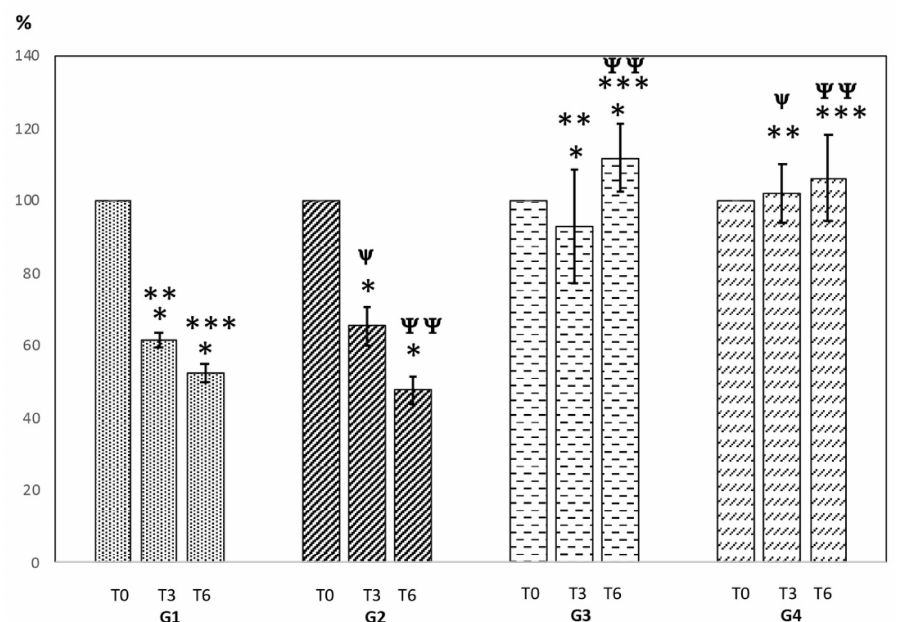
Figure 3. Cell viability % assessment in T24 cell culture (%). T0 (start of study); T3 (3 h); and T6 (6 h). Values indicate mean ± SD. Significance of the values among tested groups within each group and follow-up was determined via a Wilcoxon signed-rank test. The inter-groups at 3 and 6 h were carried out using the Kruskal–Wallis test and Bonferroni post hoc analysis. Statistical significance is depicted as follows: intra-groups (* p < 0.05); inter-groups (** p < 0.05) (T3: G1 vs. G2, G3, and G4); inter-groups ( Ψ p < 0.05) (T3: G2 vs. G3 and G4); inter-groups (*** p < 0.05) (T6: G1 vs. G2, G3, and G4), and inter-groups ( ΨΨ p < 0.05) (T6: G2 vs. G3 and